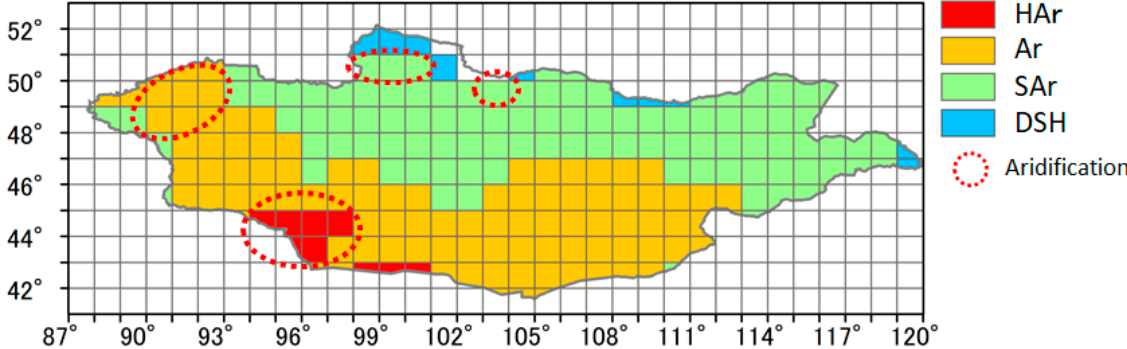
Figure 4. Spatial distribution of annual AI averaged during 2001–2013 in Mongolia with a resolution of 1° latitude × 1° longitude.